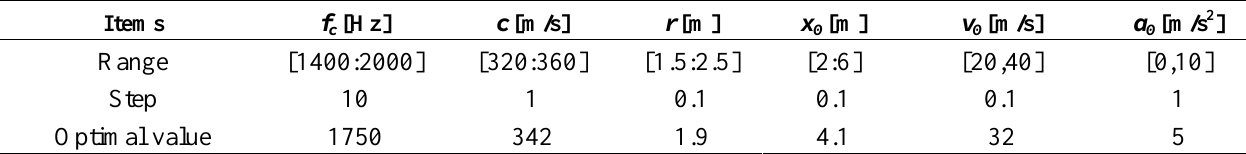
Table 5. Kinematics model parameters subset and the optimal kinematics model parameters of the bearing signal with the inner-race